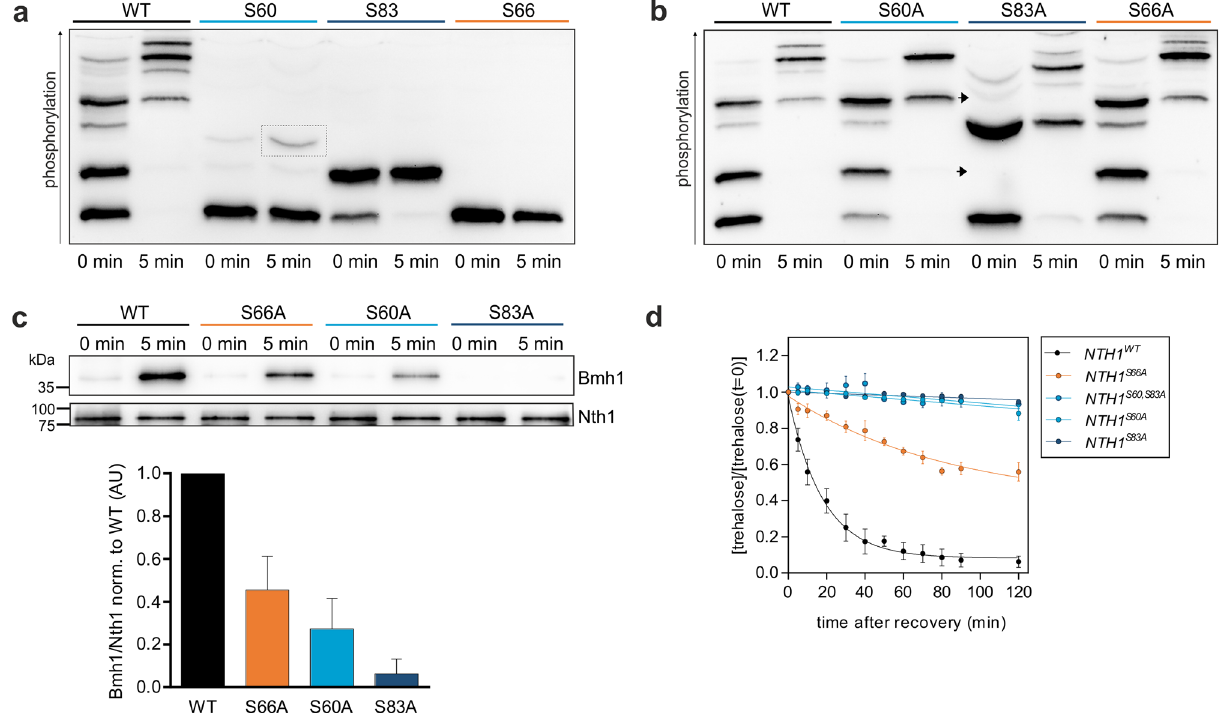
Figure 5. The PKA sites S60 and S83 are required for Bmh1 binding after glucose addition. Cells were grown to stationary phase and recovered by dilution in 1% GMM. ( a ) and ( b ) Phos-tag SDS-PAGE of cells expressing 3x-FLAG-tagged Nth1-reporter constructs ( a ) in a 5A background, ( b ) single-site mutants. Arrows denote missing bands in the S83A mutants. ( c ) Co-Immunoprecipitation of cells expressing full-length 3x-FLAG tagged Nth1 and V5-tagged Bmh1. Mean ± SD of the quantification of 4 blots from two biological with two technical replicates each. ( d ) Normalized trehalose concentration after recovery from stationary phase. SEM for at least three biological replicates with two technical replicates each. All trehalose concentrations were normalized to the concentration at t = 0 min. See Supplementary Table S3 for absolute